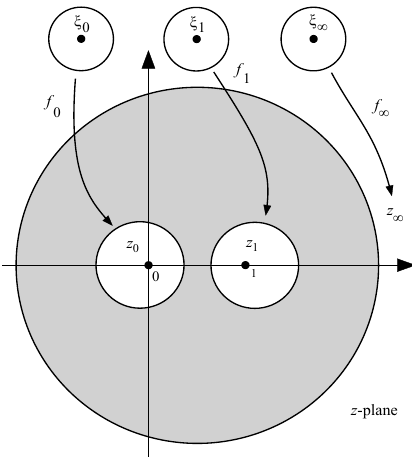
Figure 2 . Picture of the surface state de(cid:12)ning the cubic vertex. The three circles above represent the local coordinate disks (cid:24) 0 ; (cid:24) 1 ; (cid:24) 1 for the three punctures. These are transformed into regions z 0 ; z 1 ; z 1 in the complex plane by the respective local coordinate maps f 0 ; f 1 ; f 1 . The shaded region is the \interior" of the vertex, that is, the part of the surface which is not inside any local coordinate. Since the maps f 0 ; f 1 ; f 1 are SL(2 ; C ), the image of the local coordinate disks are circles. The picture shows the vertex for a generic value of the stub parameter $ > 0. Towards $ = 0, the exterior circle shrinks and the interior circles grow until they touch on the real